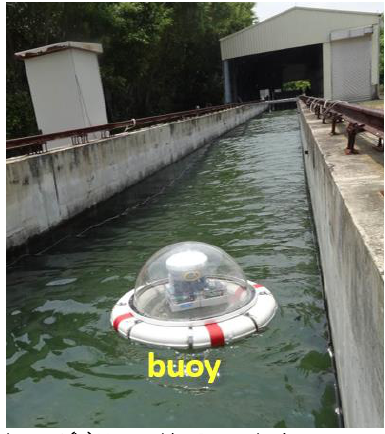
Figure 4(b) Waverider Buoy in the wave tank